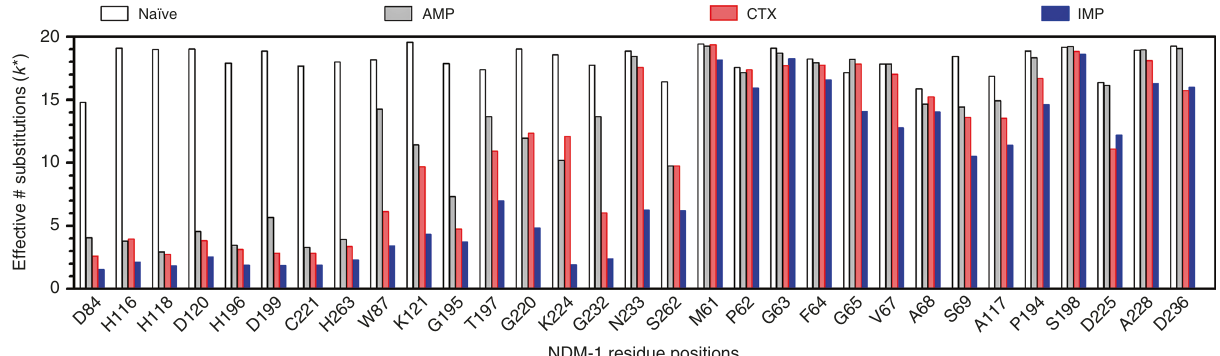
Fig. 5 Bar chart of the effective number of substitutions ( k *) for randomized positions. k * values for the naive libraries (white) and libraries after selection with ampicillin (gray), cefotaxime (red), and imipenem (blue) are shown NATURE COMMUNICATIONS| (2018) 9:4524 |DOI: